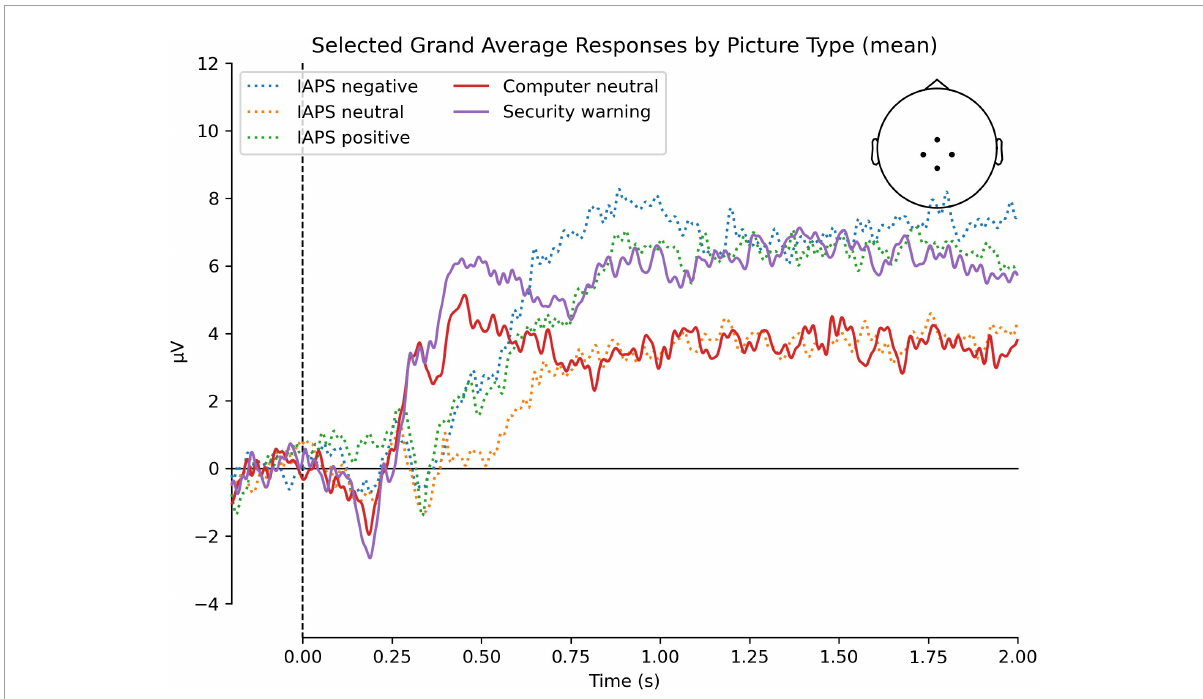
FIGURE2 Grand average waveform elicited by the IAPS negative, IAPS neutral, IAPS positive, computer neutral, and security warning stimuli. The image depicts the grand average at channels Cz, CP1, CP2, and Pz.